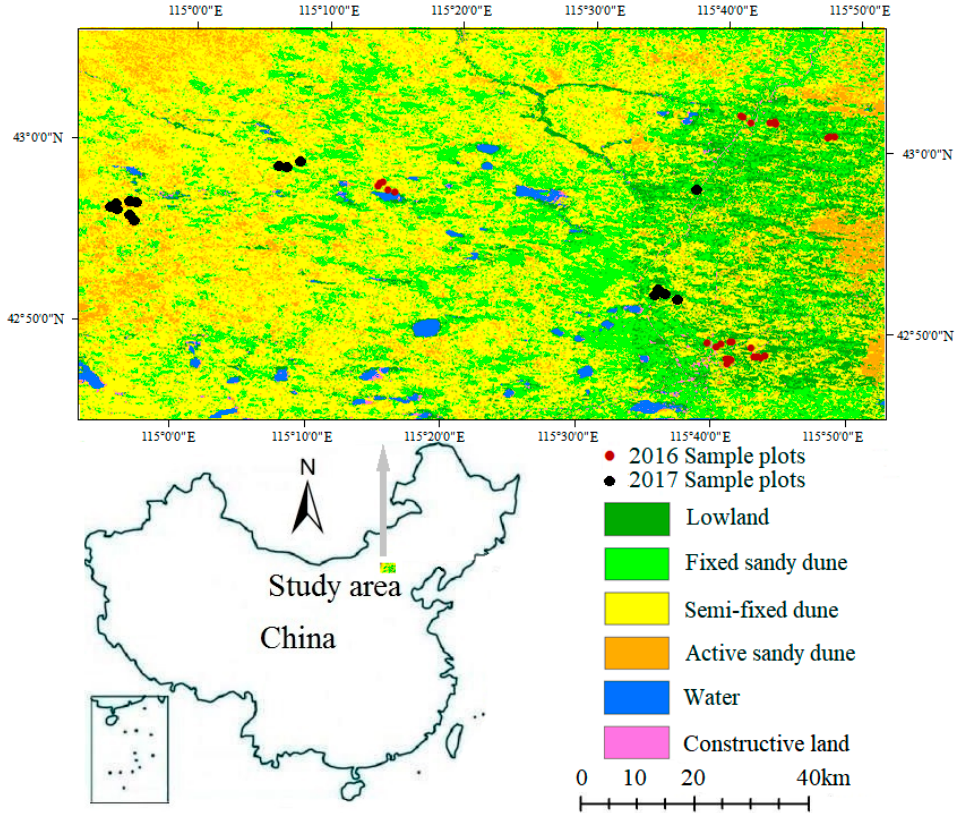
Figure 1. The sample plots in the study area, located at the center of the Hunshandak Sandland, northern China, differentiated into six main land-cover categories. The map was developed by supervised classification on Landsat 8